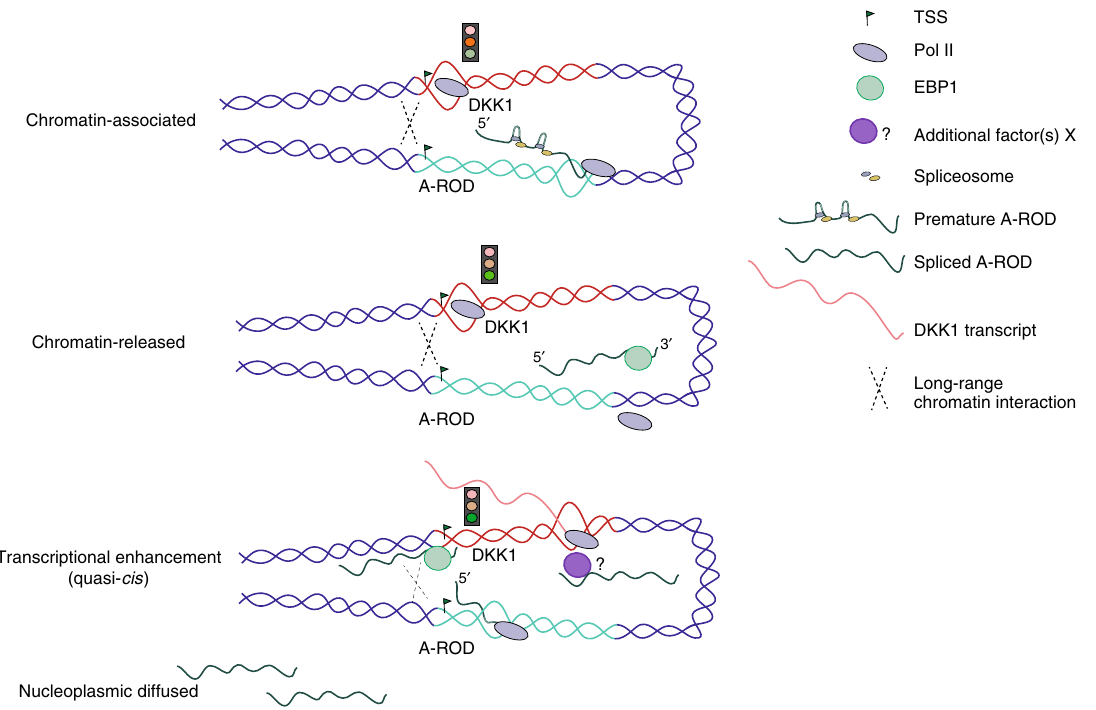
Fig. 8 A-ROD enhances DKK1 transcription with a quasi- cis mechanism. Model for A-ROD-mediated recruitment of EBP1 and regulation of DKK1 transcription at release from the chromatin-associated template, and within the physical proximity of the pre-established chromosomal